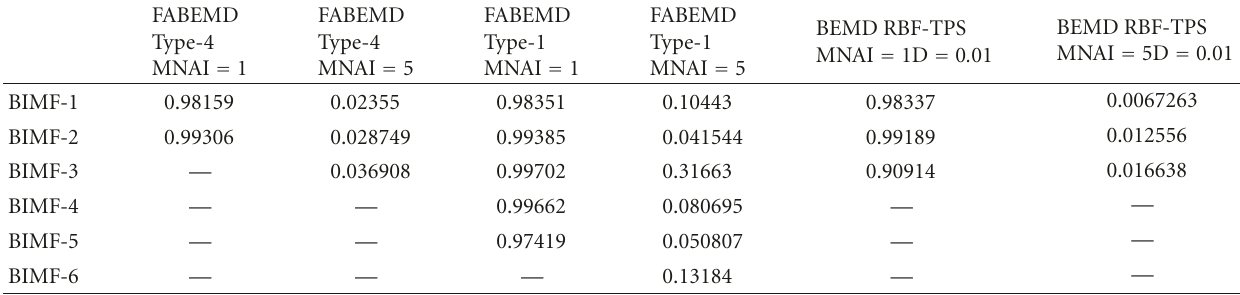
Table 3: Comparison among various FABEMD/BEMD for the STI in terms of achieved stopping point SD for each BIMF.